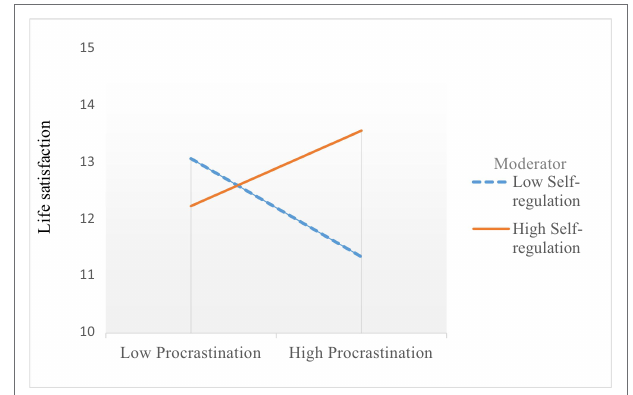
FIGURE 1 | Simple slope figure for the moderation effect in the Chinse group ( N =